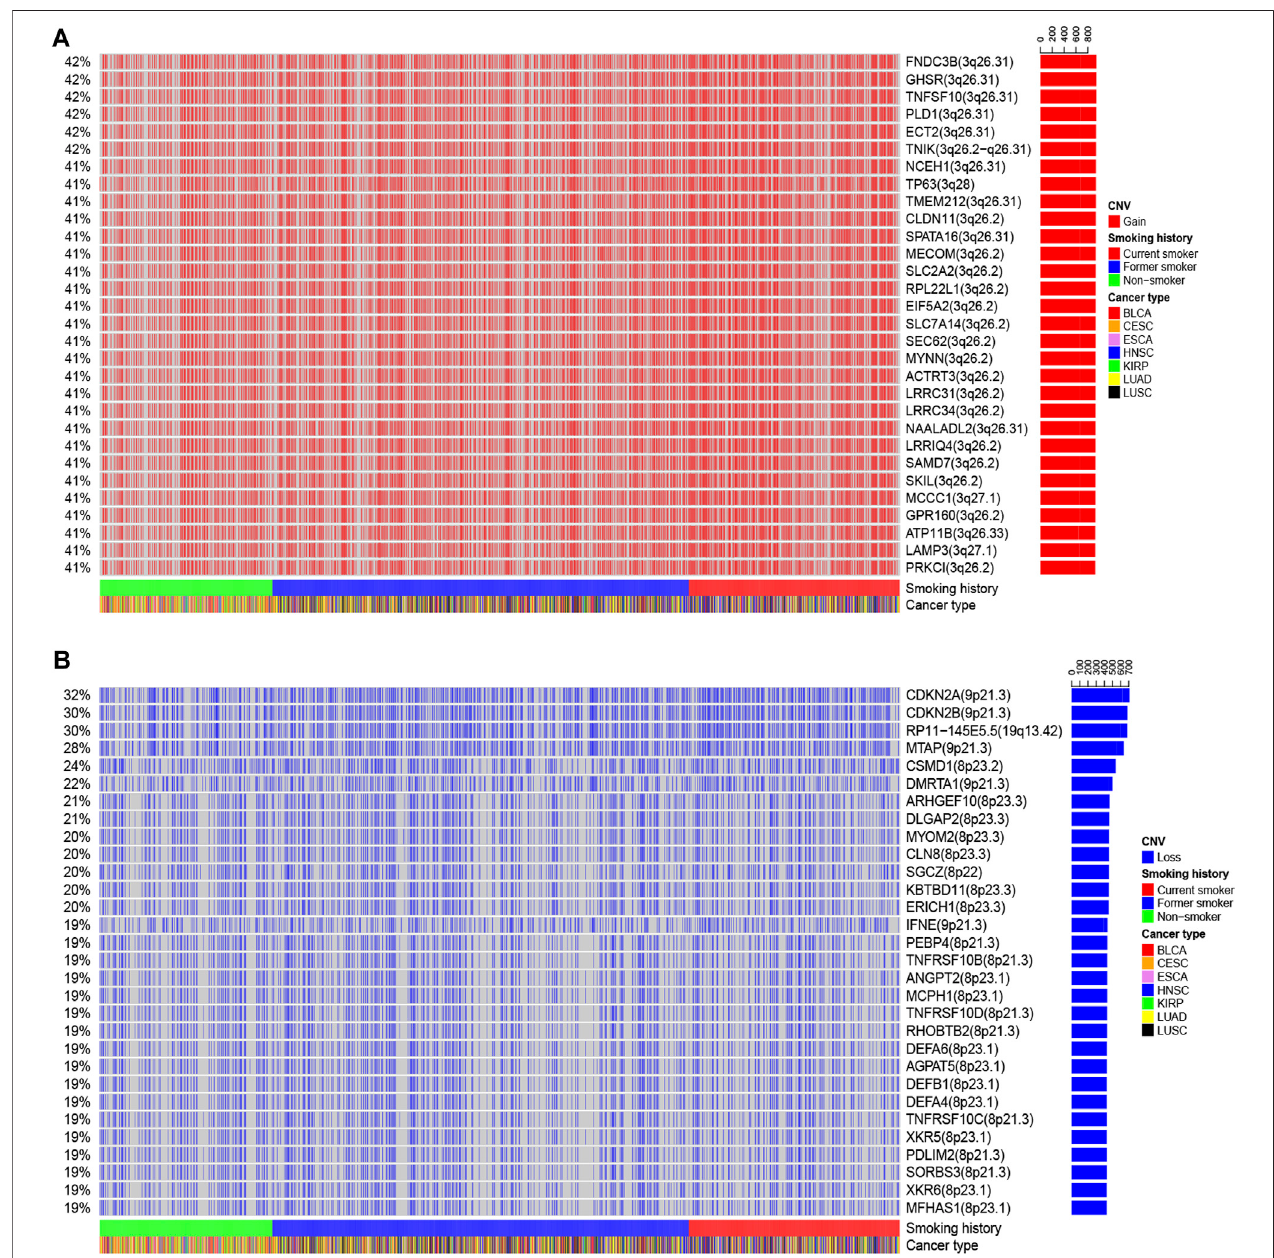
FIGURE 7 | The landscape of the top 30 genes in the incidence of (A) CNV gain and (B) CNV loss in patients with different smoking histories.